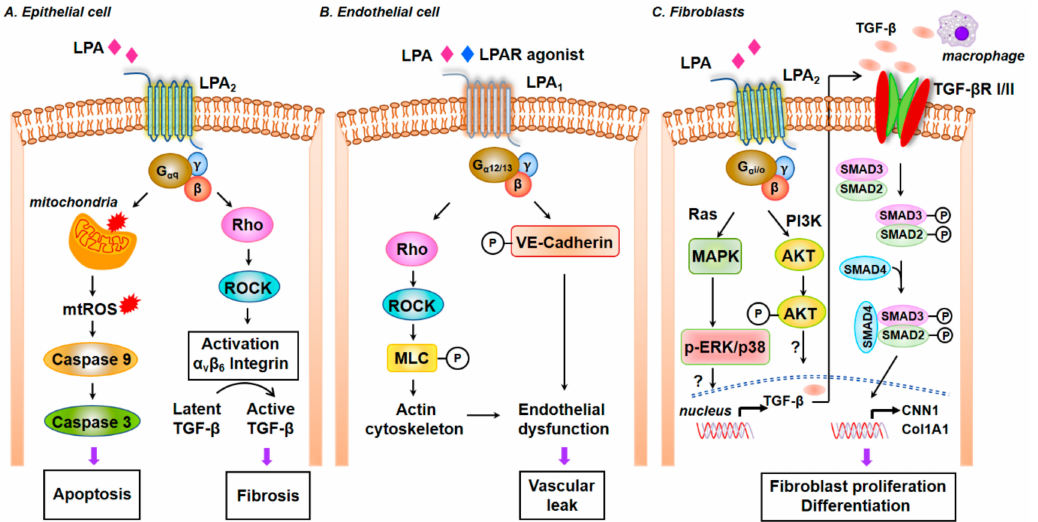
Figure 6. Role of lysophosphatidic signaling via lysophosphatidic acid receptors in